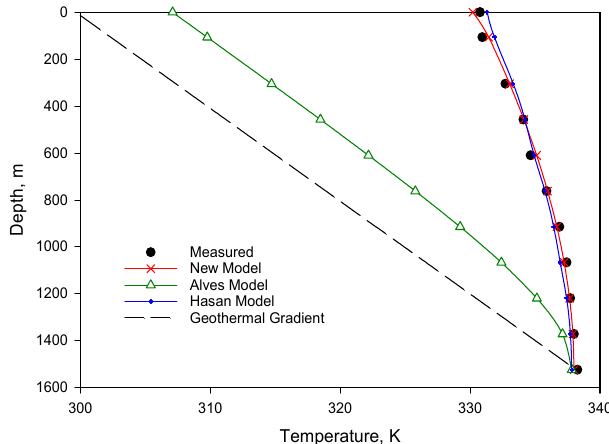
Figure 7. Comparison of data for the Thompson Well.